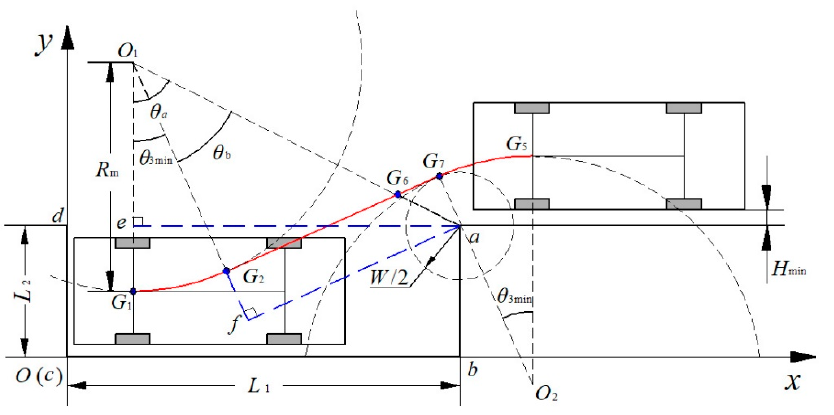
Figure 11. Extreme position of parallel parking with θ 3min .